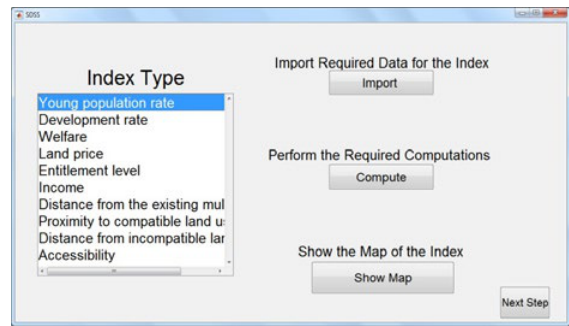
Fig. 4: The user interface of the SDSS; First step: Production of the map of each index